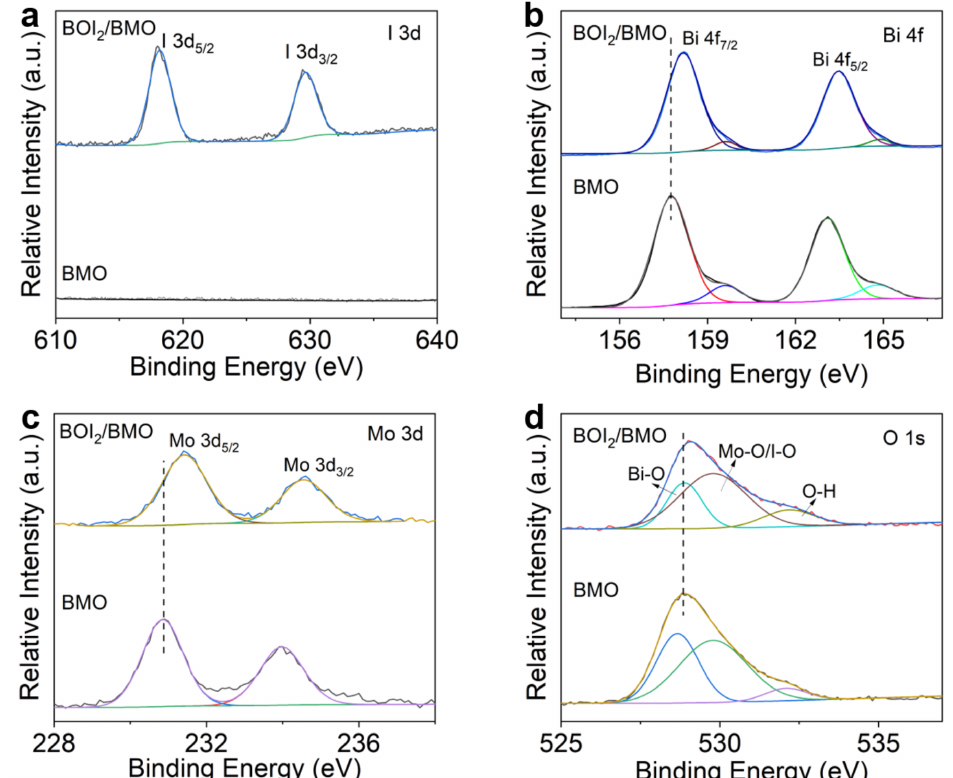
Figure 2. High-resolution XPS spectra of ( a ) I 3d, ( b ) Bi 4f, ( c ) Mo 3d, and ( d ) O 1s for BMO and BOI 2